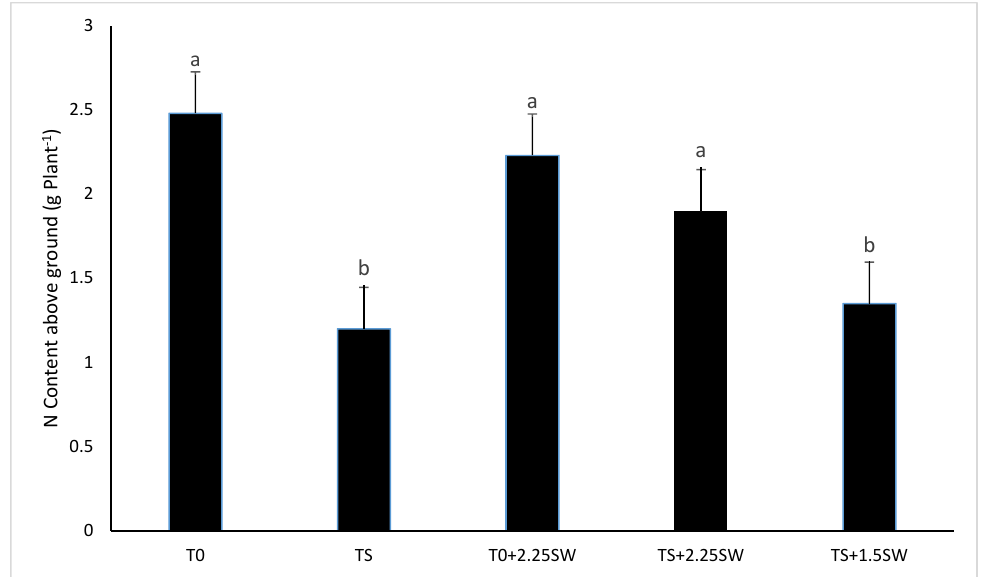
Figure 3. N content above ground in 2 year Hass avocado plants grown in pot for 240 days with different treatments (T0: distilled water, TS: saline water (9 mM NaCl), T0 + 2.25SW: distilled water + 2.25 mL seaweed, TS + 2.25SW: saline water (9 mM NaCl) + 2.25 mL seaweed T0 + 1.5 mL seaweed) with 6 replicates per treatment. Means with different letters indicate significant differences between treatments (Tukey test p <